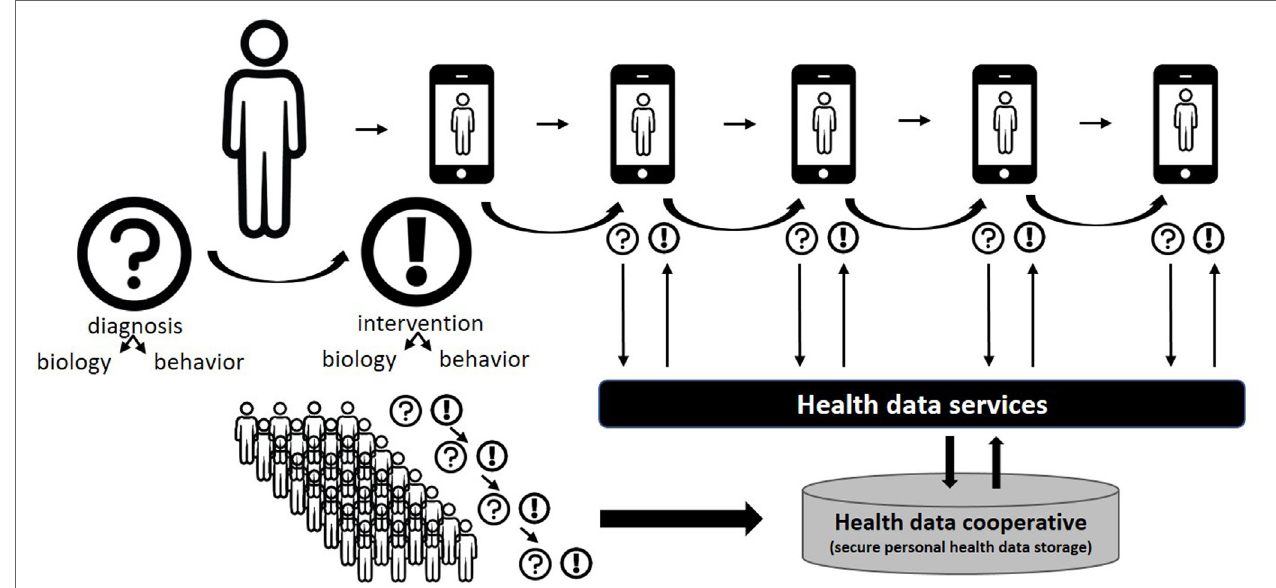
FiGURe 3 | Schematic overview of a “life companion” approach. The citizen–patient interacts with a single ehealth (eHealth) platform (any combination of phone, desktop, life coach, healthcare provider) and receives interventions in all relevant areas (diet and lifestyle, behavior, information, etc.) at the right time in the right message format, based on both initial and continued diagnosis. The intervention is generated by “health services,” i.e., models that exploit personal health and behavior data. Timelines of diagnostic and intervention information are owned by the citizen/patient and may be shared within a community (health data cooperative), thus further strengthening the personal health data service with a “big data”